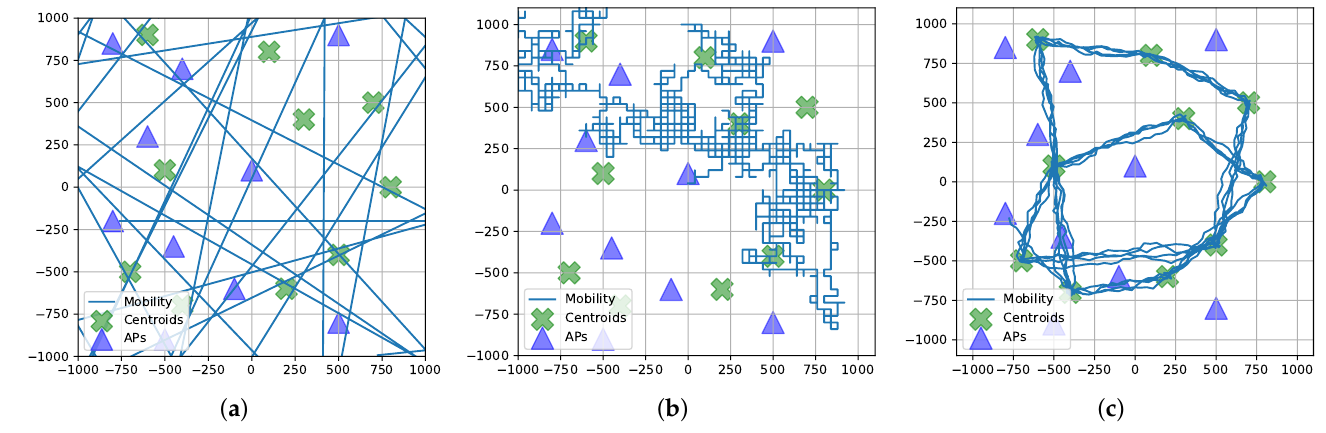
Figure 1. Examples of different mobility models’ patterns using five access points (APs) and ten centroids. ( a ) Random direction mobility model. ( b ) Random walk mobility model. ( c ) RSSGM mobility